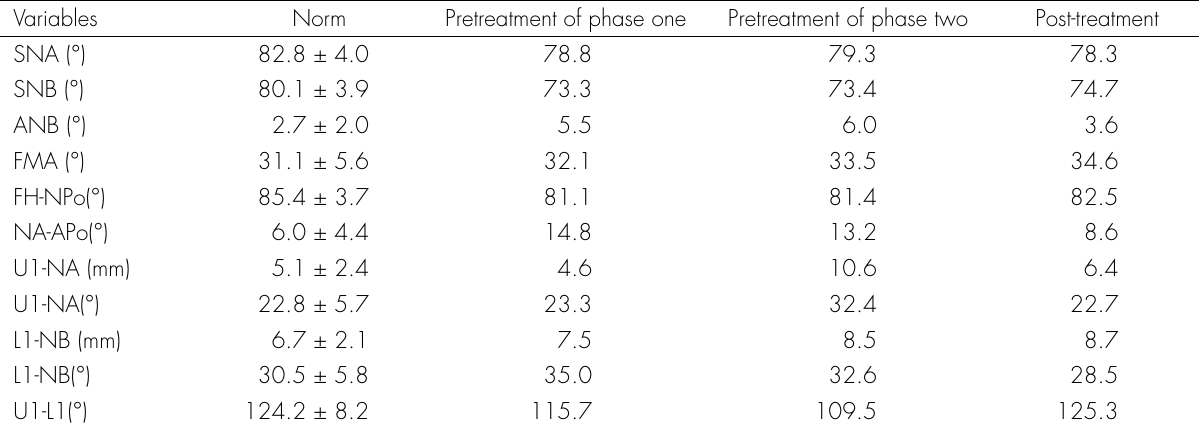
Table I. Cephalometric